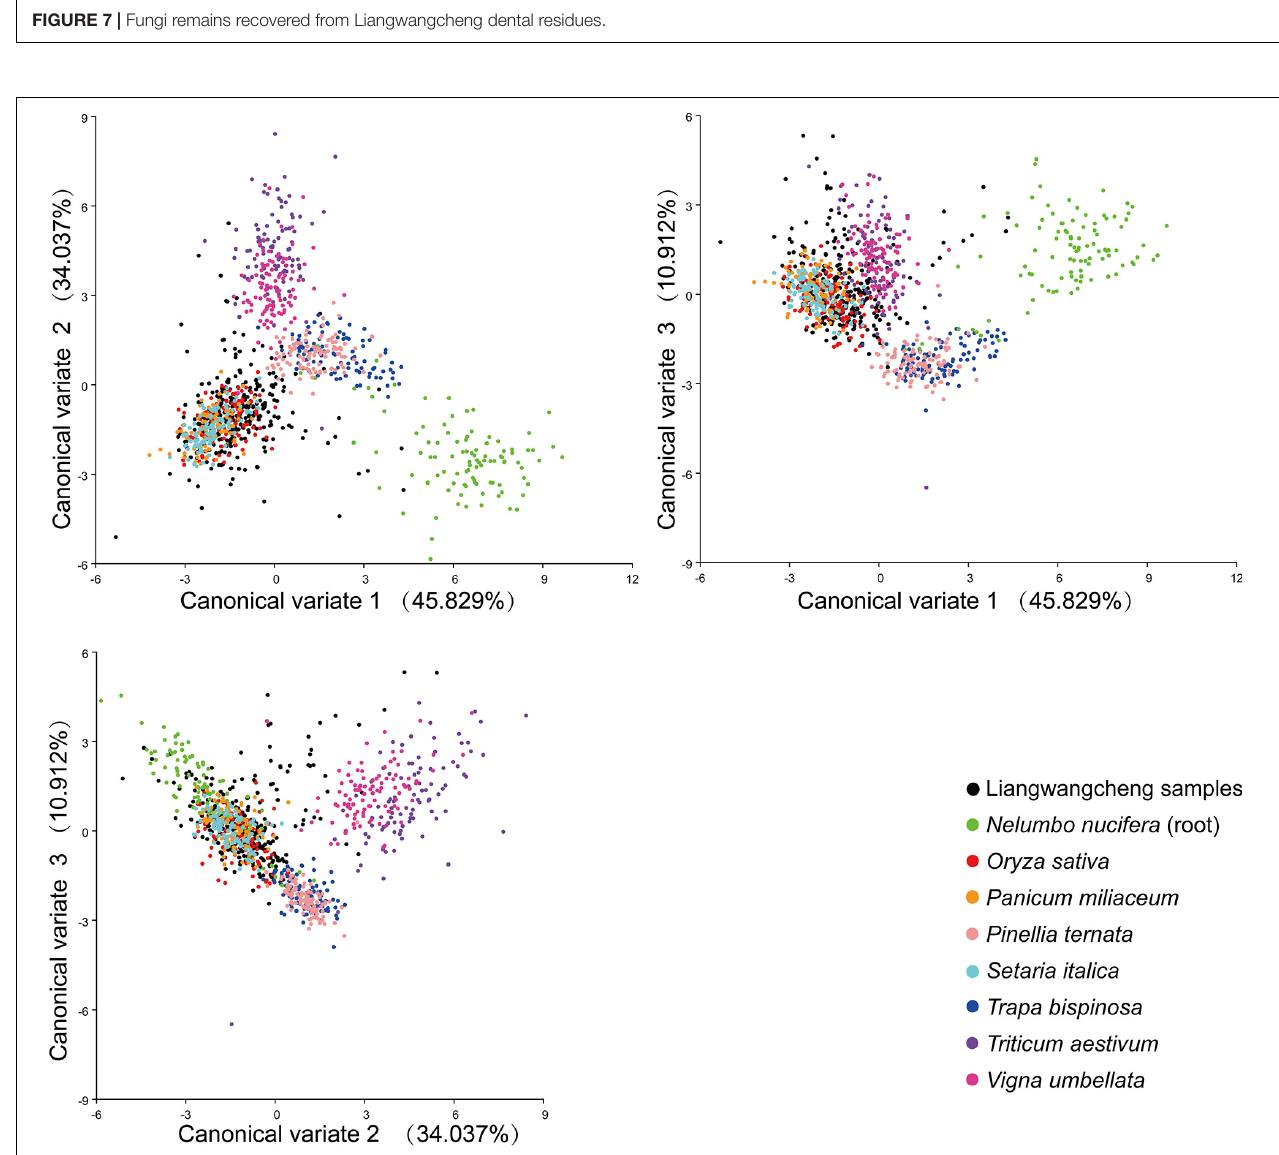
FIGURE 8 | Canonical variate scatter plot of CV1, CV2, and CV3 accounting for approximately 90% of variation.